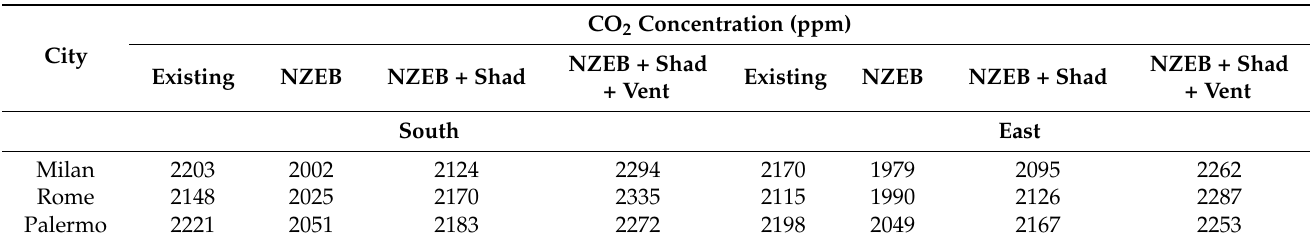
Table 6. Average CO 2 concentration in the selected cities, for south- and east-oriented classrooms.